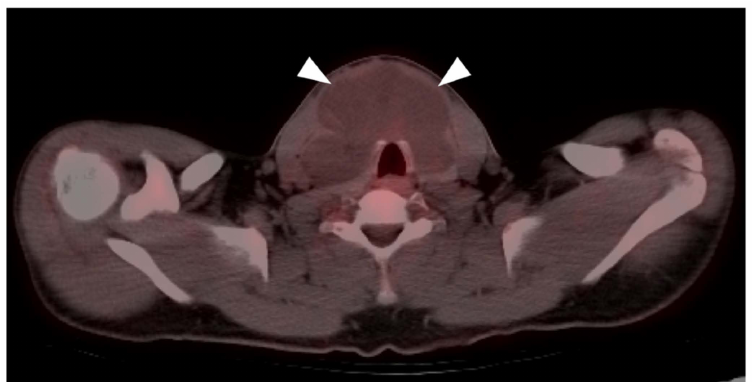
Figure 24. Myxoid liposarcoma of the central compartment of the neck. On an axial FDG PET-CT image of the neck, a cystic tumor in the central compartment of the anterior neck was observed to be mildly metabolically active and higher in attenuation than most lipomas (white arrows). Myxoid liposarcomas can be multi-loculated on MRI.